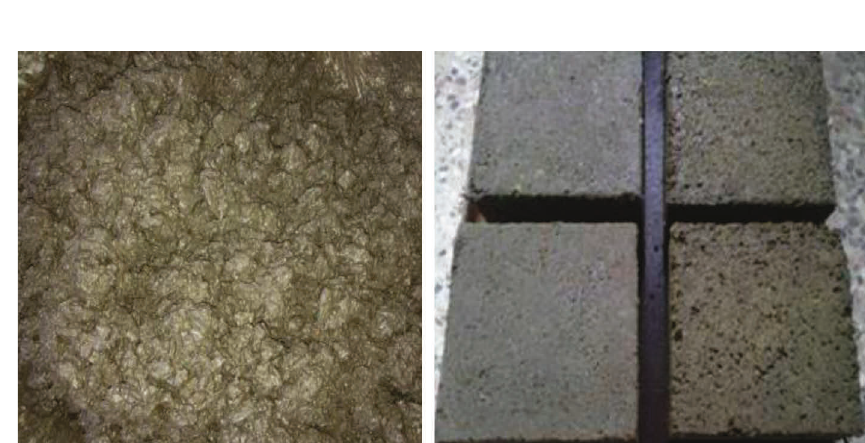
Figure 5: SDA-concrete produced.